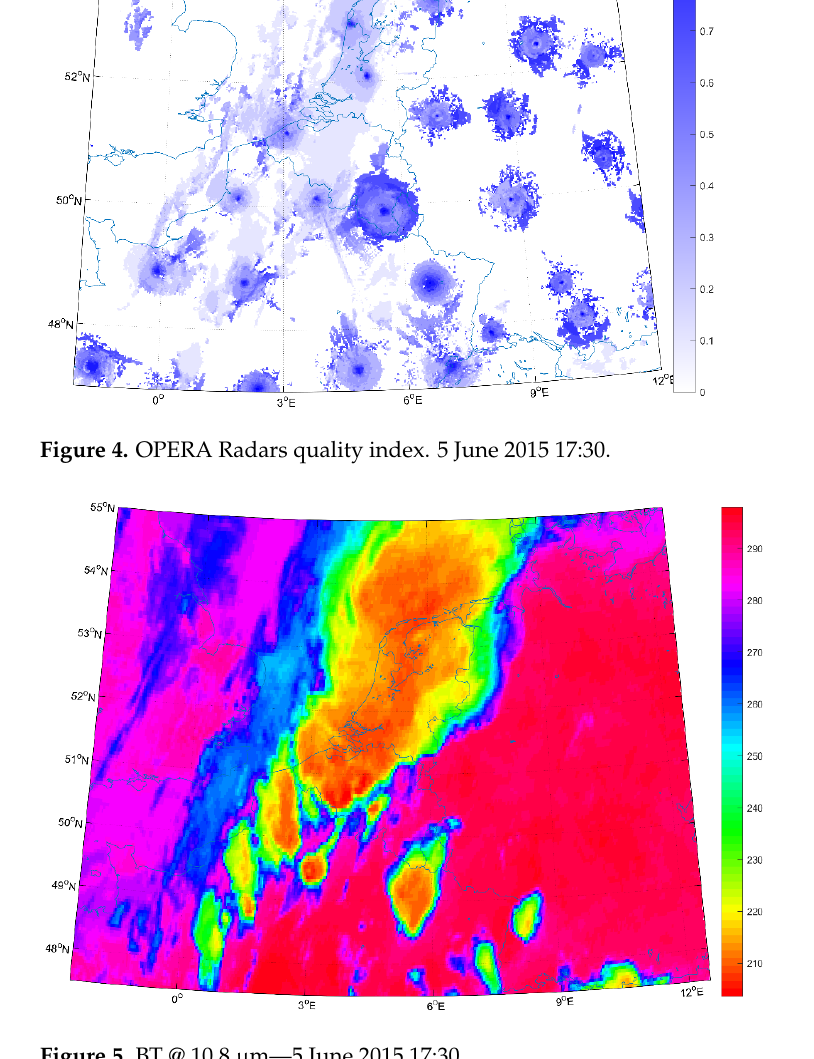
Figure 5. BT @ 10.8 μ m—5 June 2015 17:30.